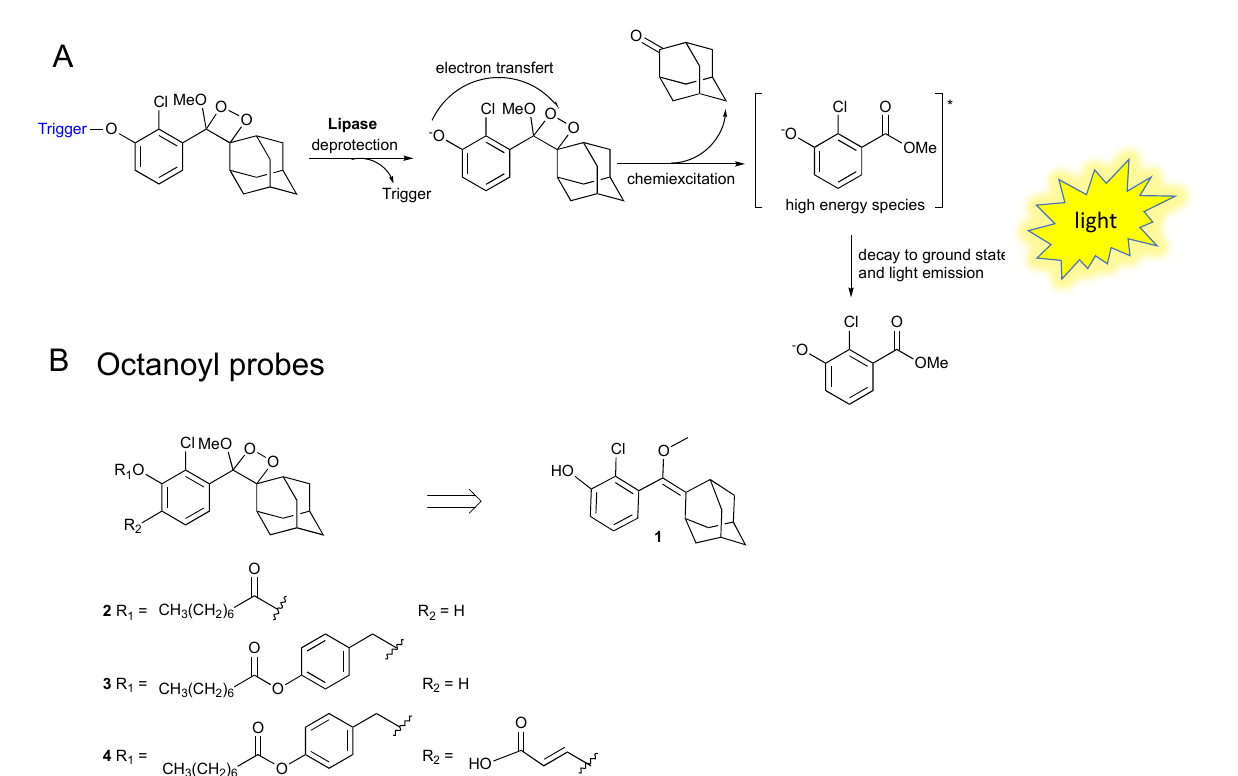
Figure 1. ( A ) Chemiexcitation mechanism of phenoxy-1,2-dioxetane luminophores; ( B ) structures of the synthesized luminophores, * indicates that the molecule is in an electronically excited form .